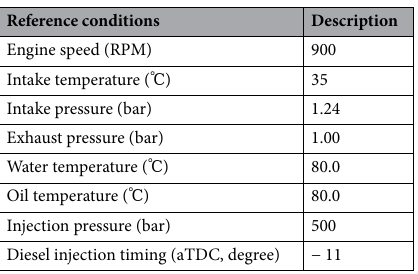
Table 4. The reference optical engine experimental conditions.